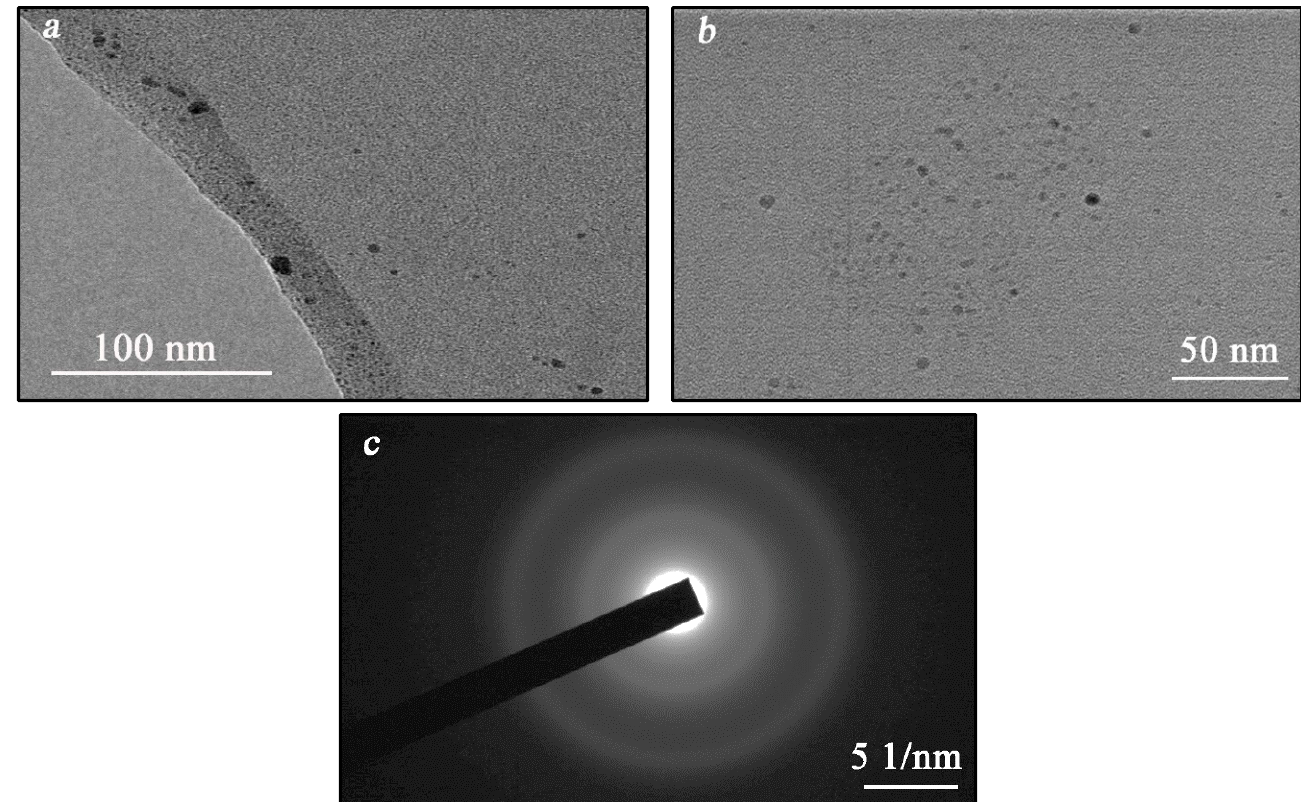
Figure 3. TEM images of CuI-PPy rinsed samples: ( a ) sample 4, ( b ) sample 7, ( c ) electron diffraction in selected area (SAED)